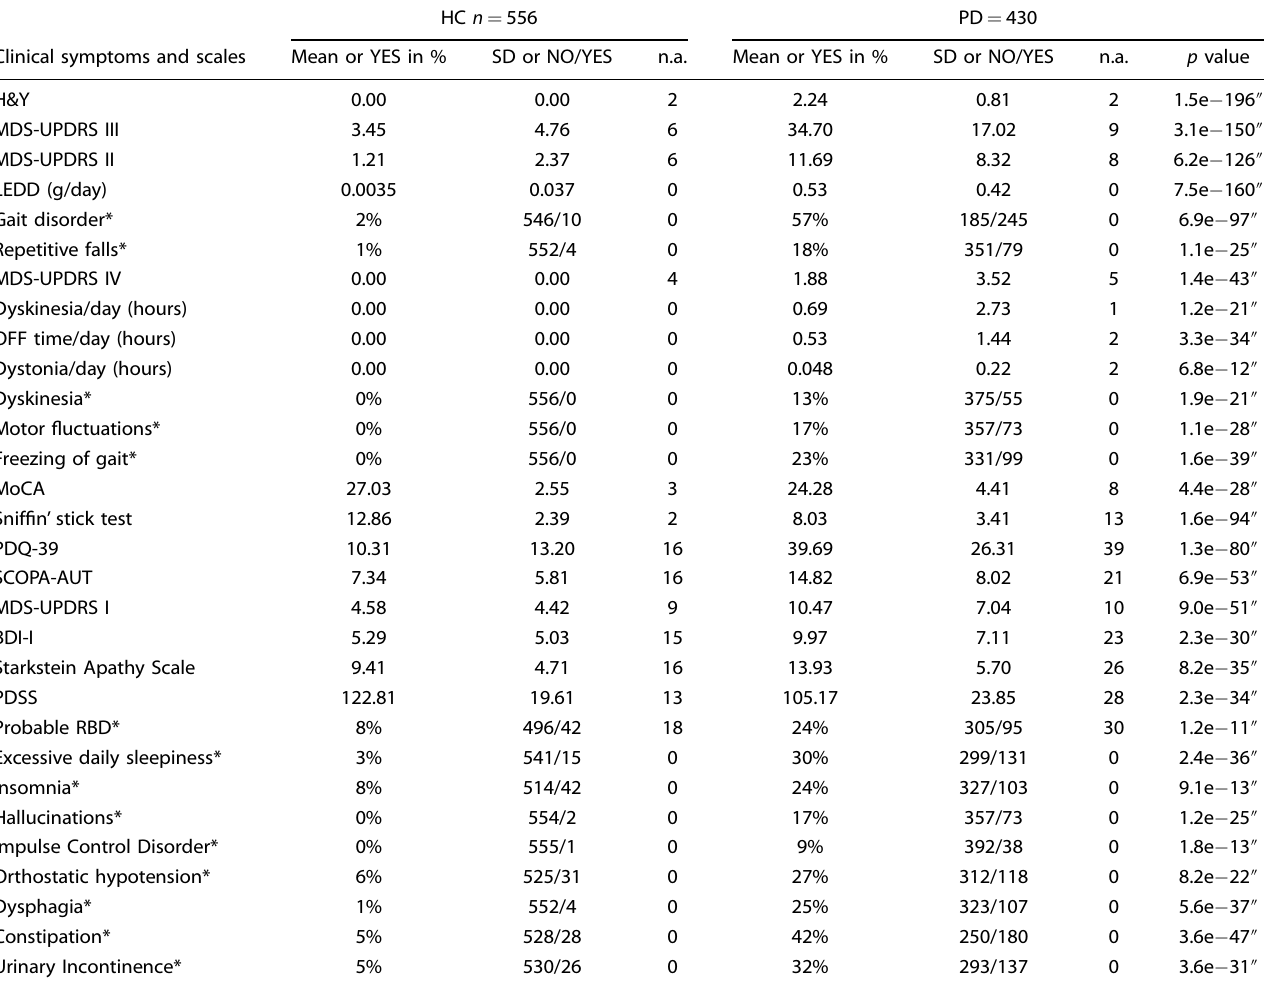
Table 2. Overview of dataset with clinical variables in healthy control group (HC) and Parkinson ’ s disease patients (PD) with p values from Mann – Whitney U test for numerical variables and Fisher ’ s exact test for binary